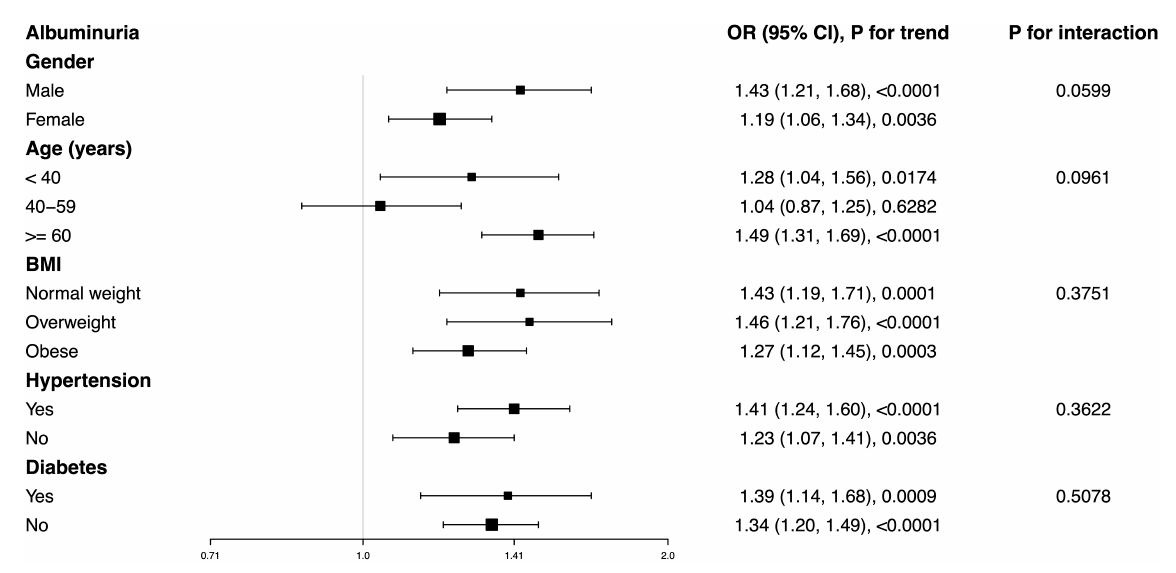
FIGURE3 Subgroup analysis for the association between WWI and albuminuria. None of the stratifications including gender, age, BMI, hypertension, and diabetes status significantly affected the positive association of WWI and